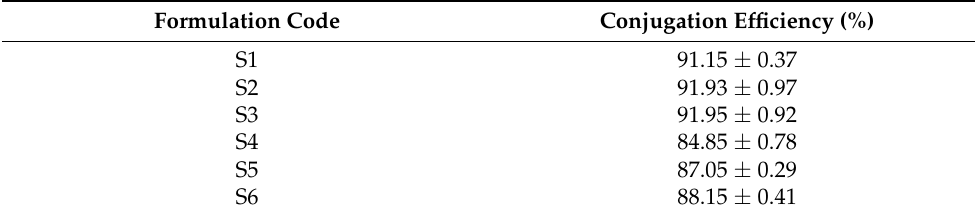
Table 1. Conjugation Efficiency of IBU hydrogel with and without